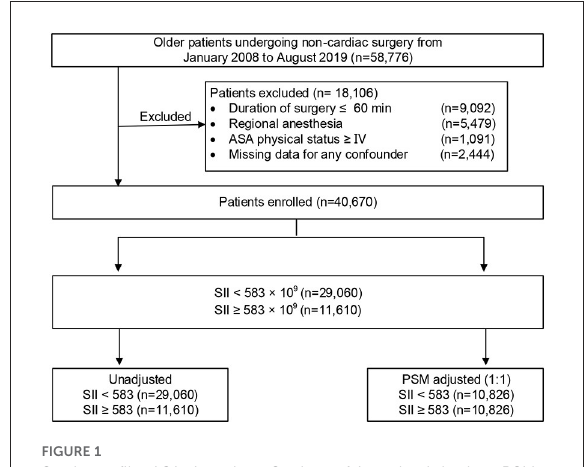
FIGURE1 Study profile. ASA, American Society of Anesthesiologists; PSM, propensity score